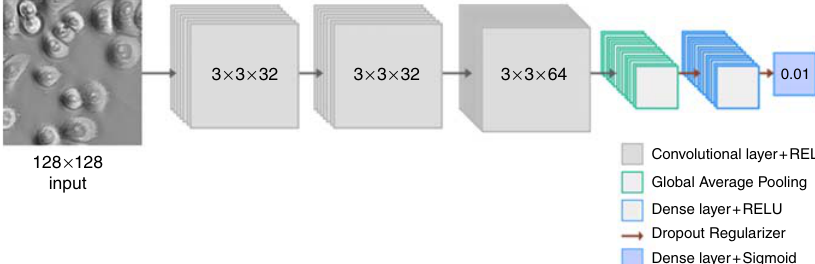
Figure 3. The architecture of our convolutional neural network based on the ScaffoldNet architecture